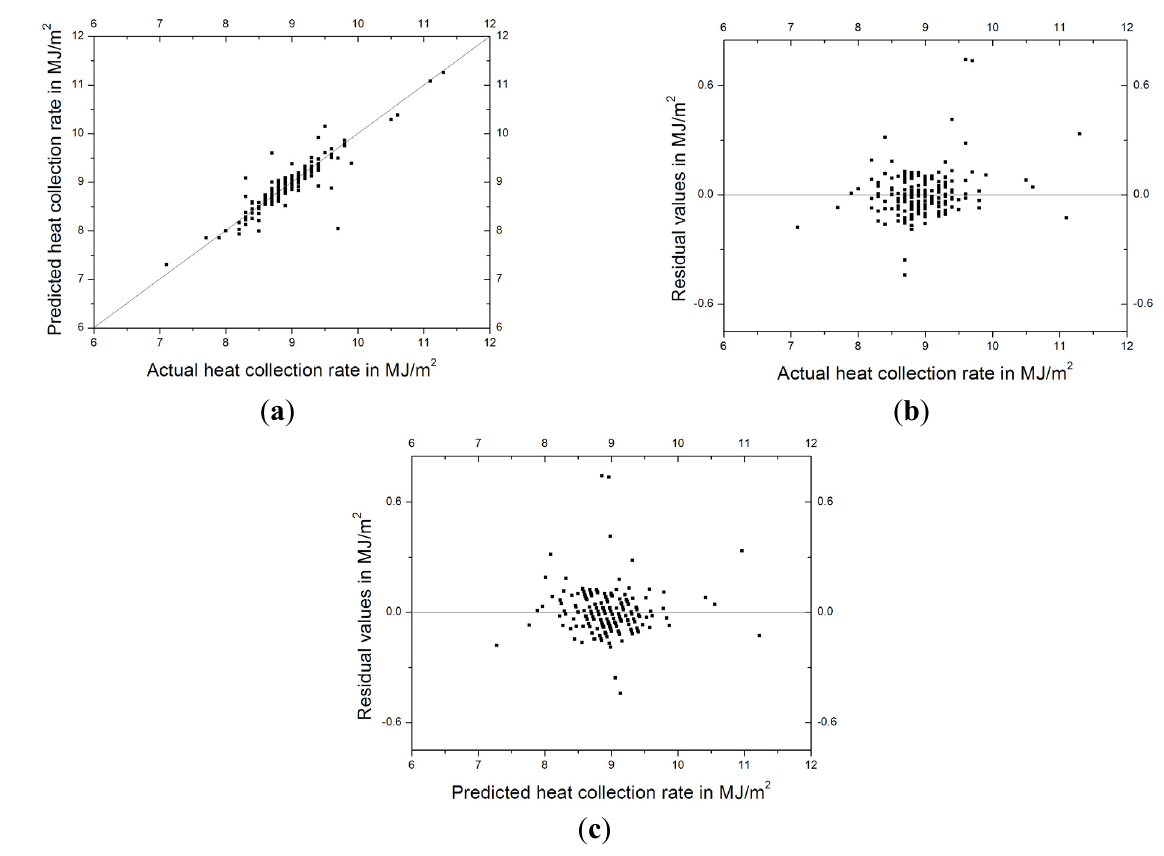
Figure 7. Testing results of 137 samples using the MLFN-3 for the prediction of heat collection rate. ( a ) Predicted values versus actual values; ( b ) residual values versus actual values; ( c ) residual values versus predicted